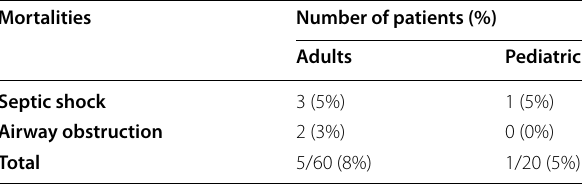
Table 5 Mortality after of the